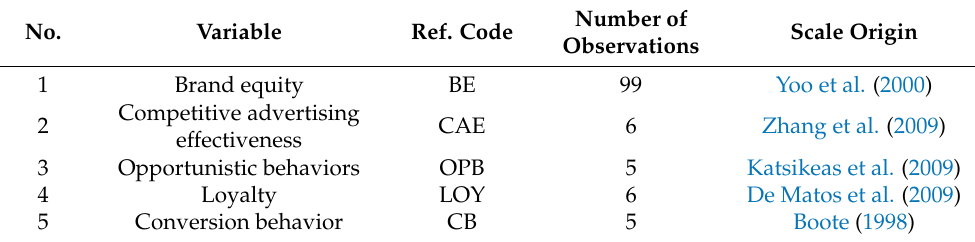
Table 1. Origin of the scale of variables.